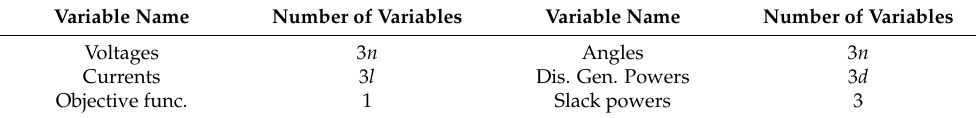
Table 2. Number of variables for the power flow problem in three-phase